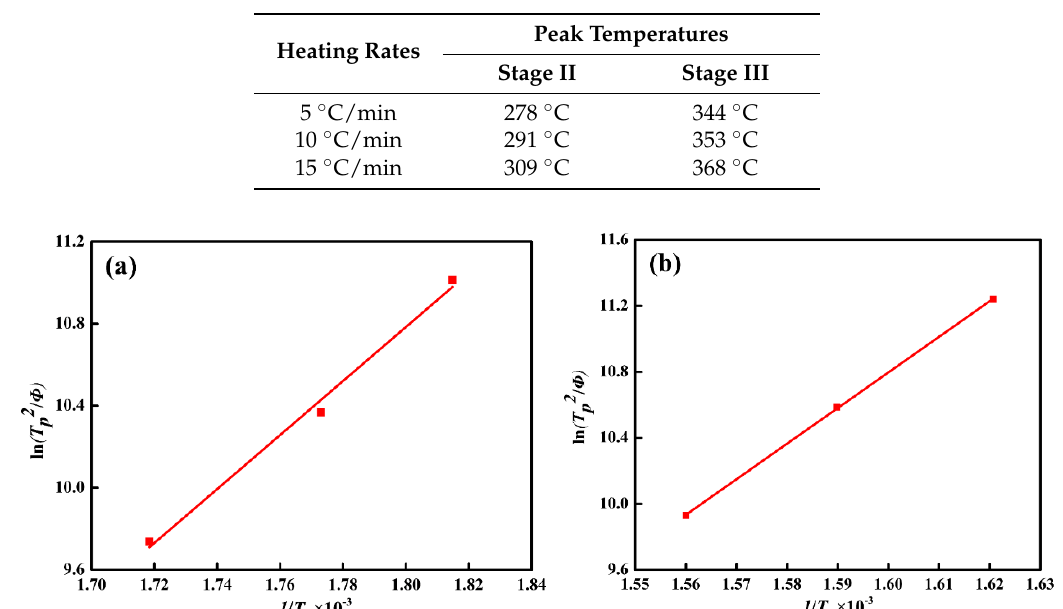
Figure 3. Kissinger analysis (l n(𝑇 𝑃2 /∅) versus 1/𝑇 𝑃 × 10 −3 ) for the determination of the individual activation energy of Stage II ( a ) and Stage III ( b ) without applied stress.